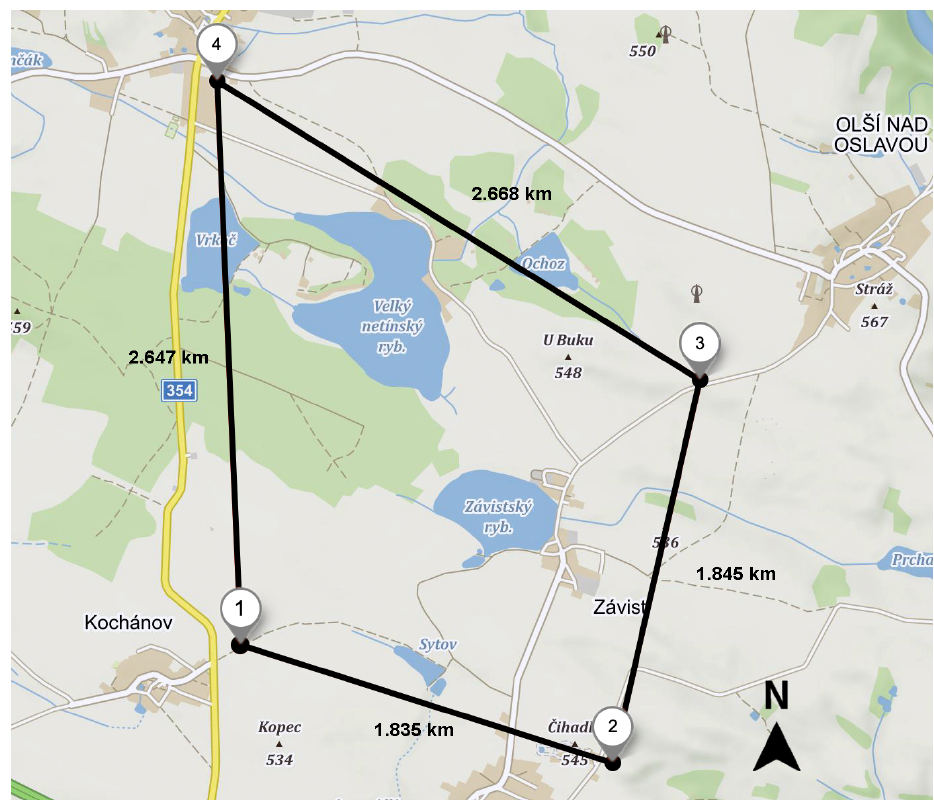
Figure 6. Selected positions of the gateways (GWs) used for simulations and empirical